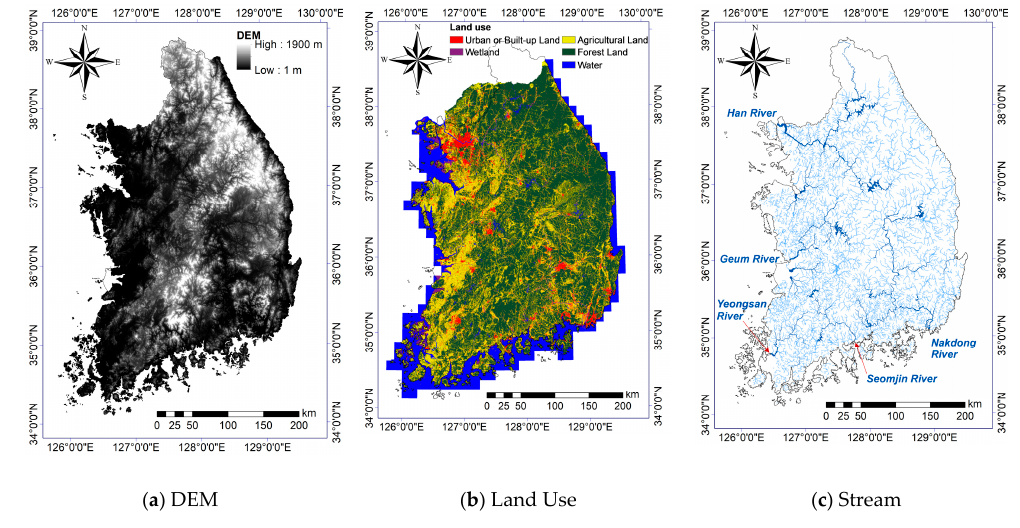
Figure 2. HSPF topographical input data.